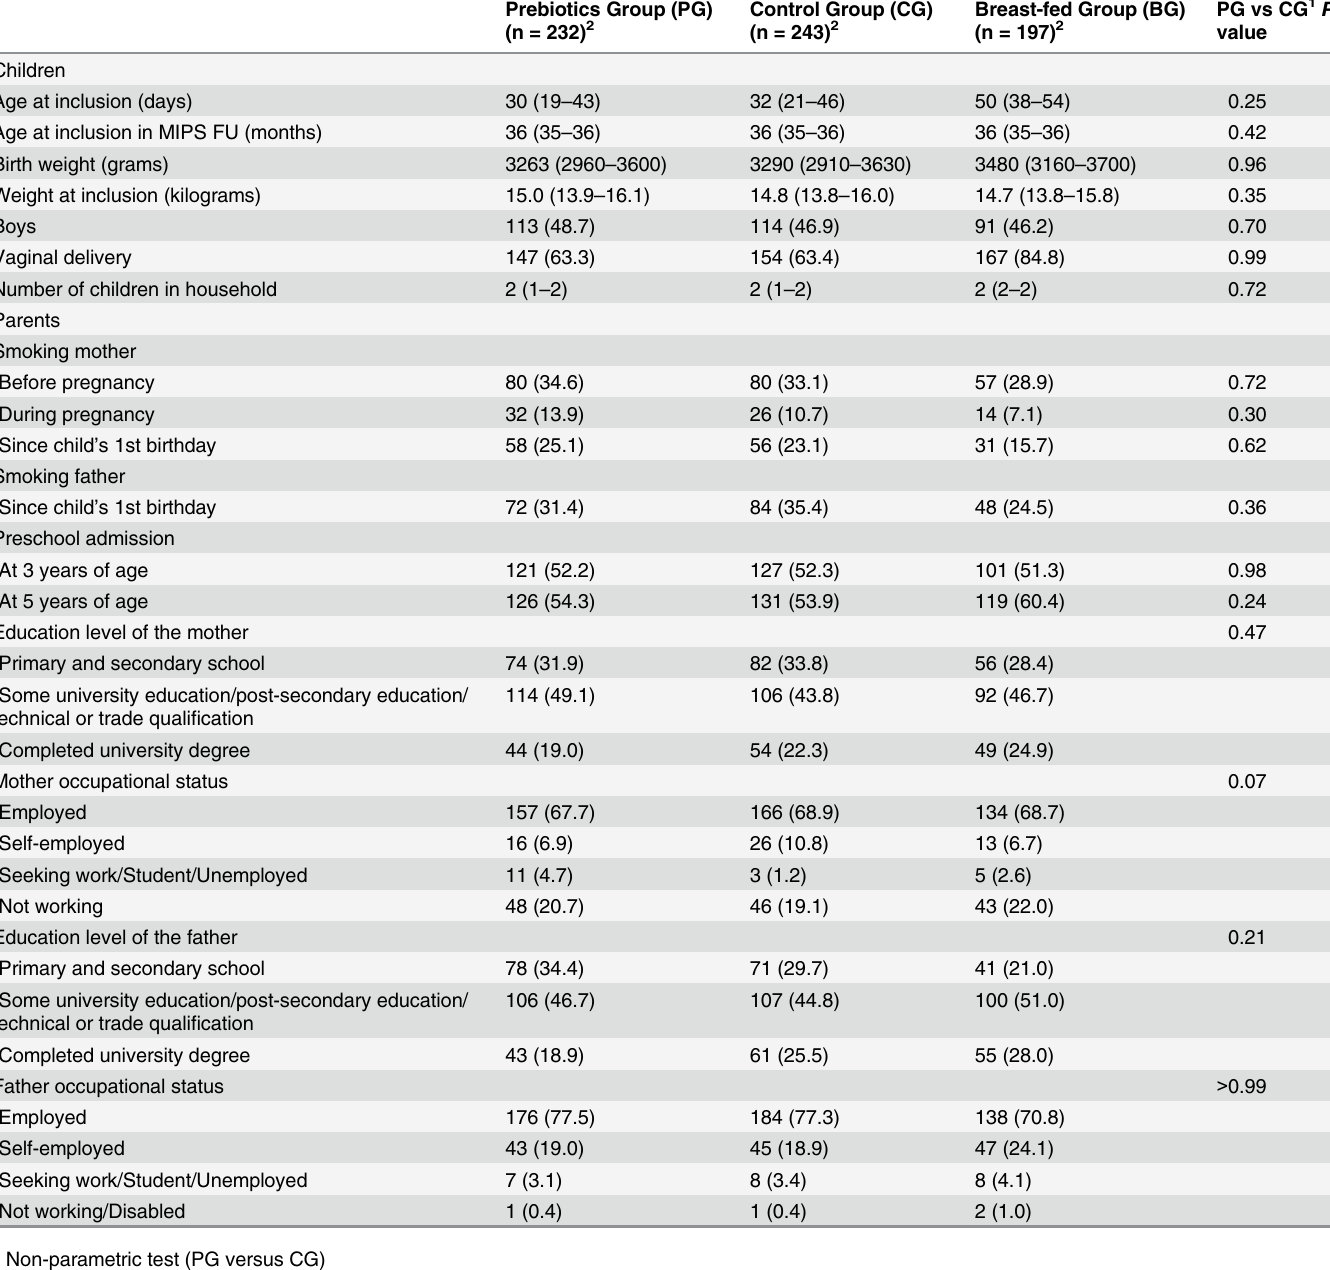
Table 2. Baseline